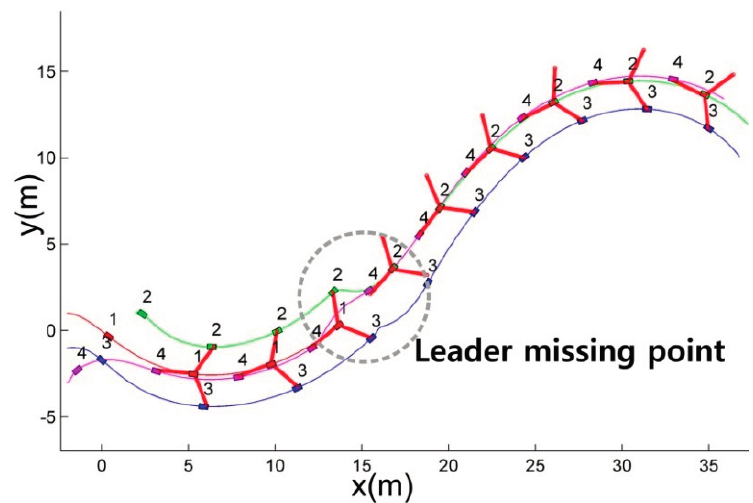
Figure 5. The route of the robots in the leader disappearing situation.